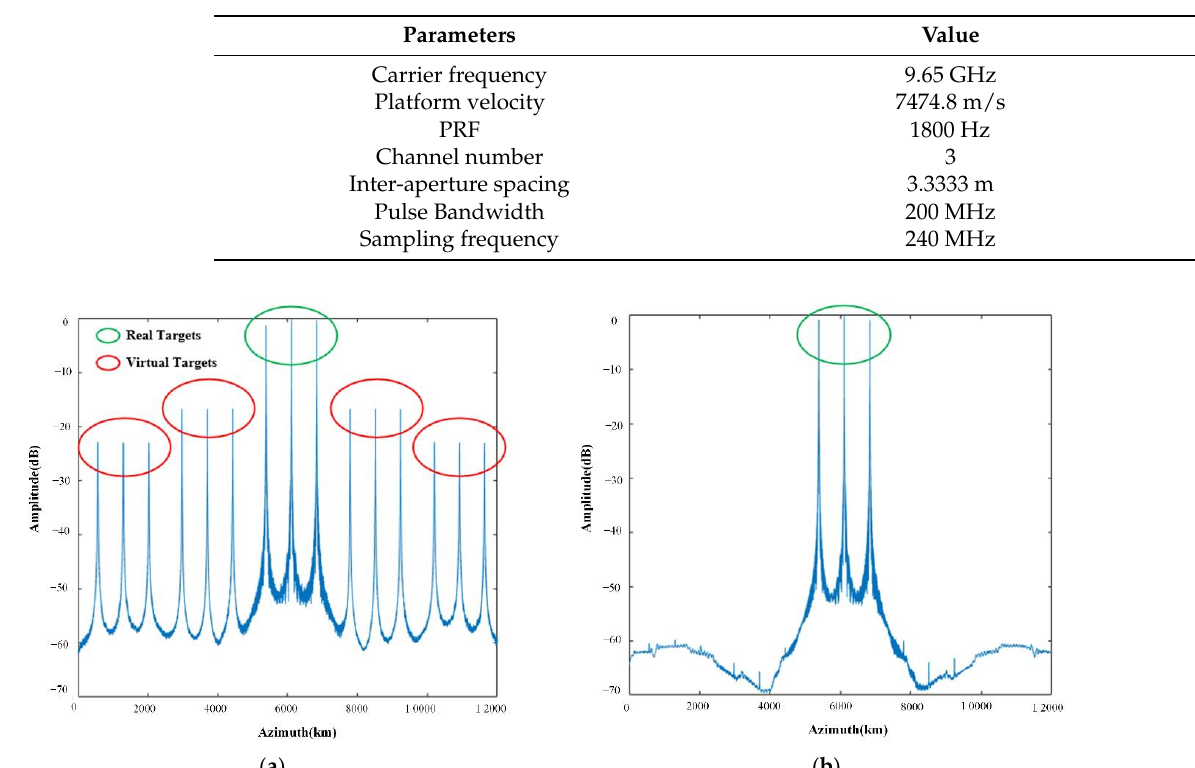
Table 1. Simulation parameters.